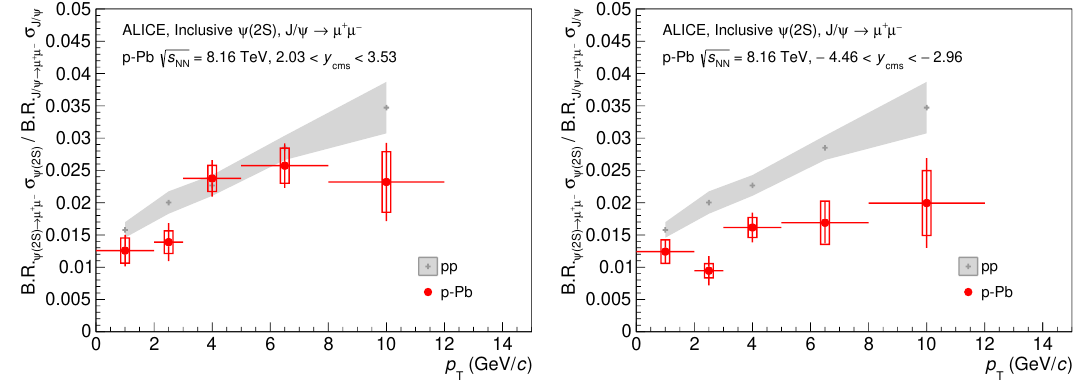
Figure 5 . The ratio B : R : (cid:27) (2S) = B : R : (cid:27) J = as a function of p T , for p-Pb col- (2S) ! (cid:22) + (cid:22) (cid:0) J = ! (cid:22) + (cid:22) (cid:0) p lisions at s NN = 8 : 16 TeV, compared with the corresponding pp quantity, shown as a grey band p and obtained via an interpolation of results at s = 7, 8 and 13 TeV [51]. The error bars represent the statistical uncertainties, while the boxes correspond to uncorrelated systematic